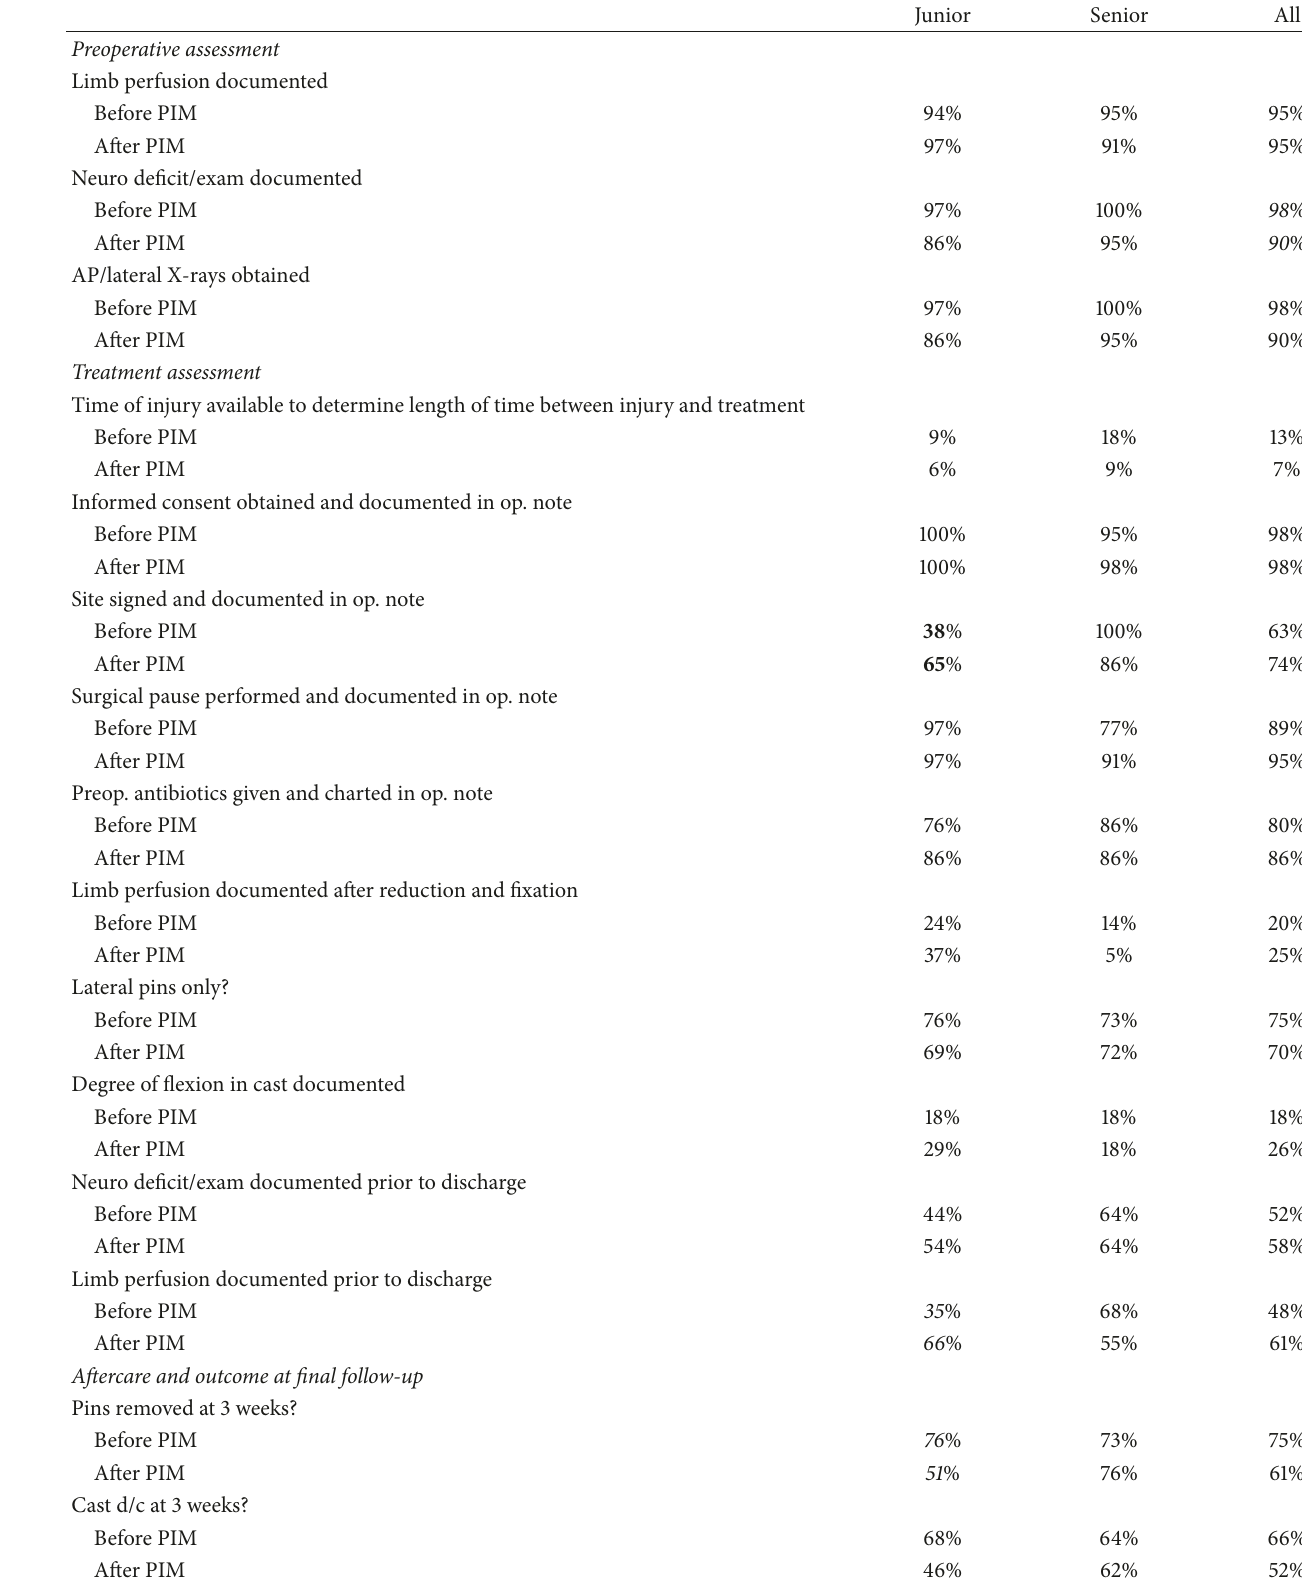
Table 1: Detailed response rates for PIM questions before and after PIM education, based on level of experience as well as for the cohort as a whole. Significant differences are noted via bold values; differences at alpha < 0.10 are in italics.